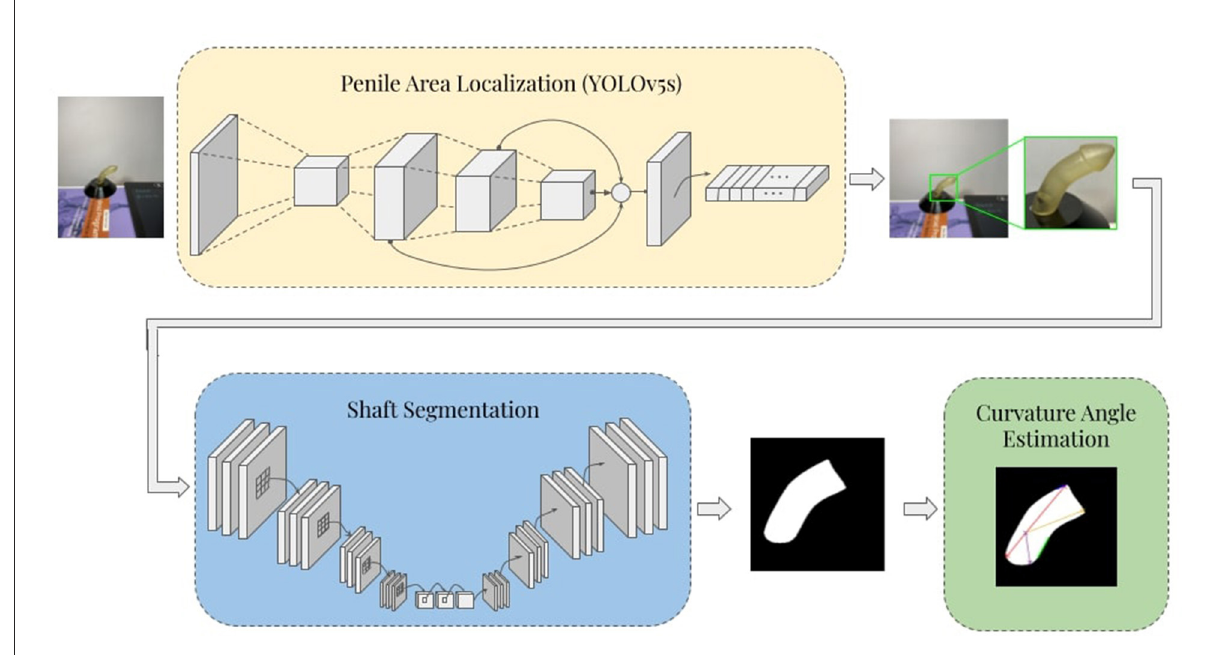
FIGURE1 Schematic diagram of the proposed penile curvature angle estimation pipeline.